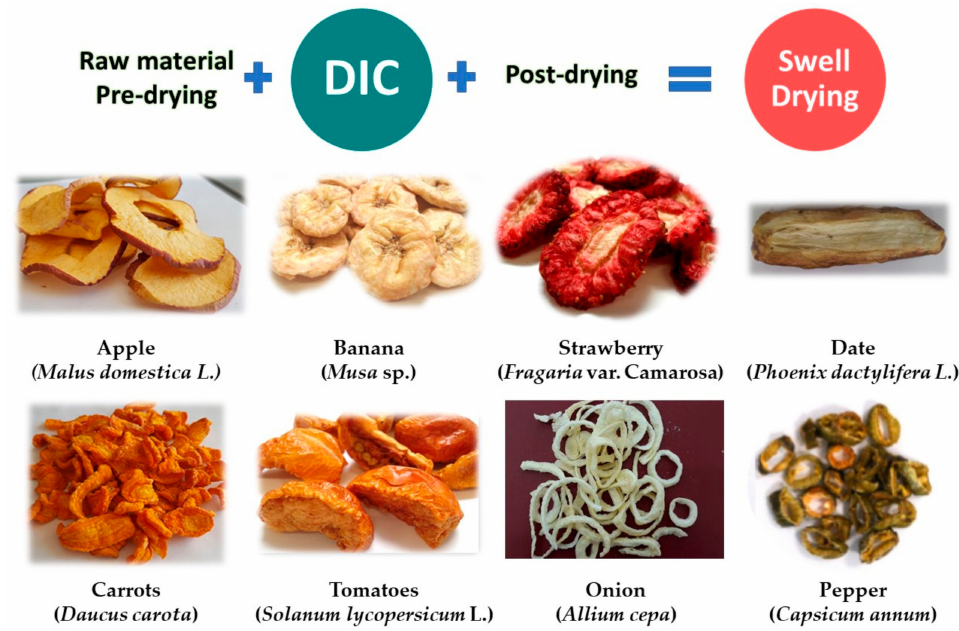
Figure 5. Examples of swell-dried fruit and vegetable